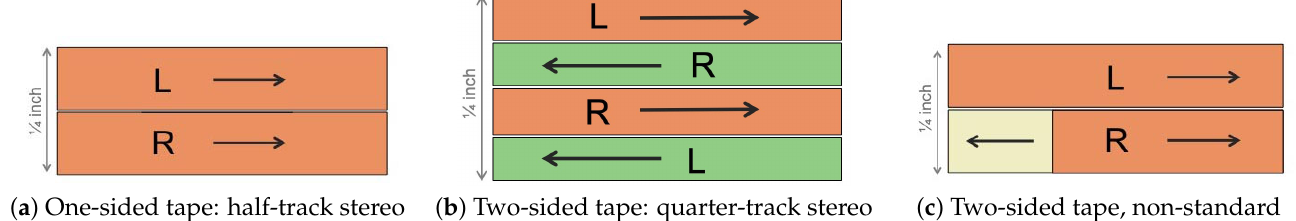
Figure 2. Examples of standard and non-standard track configurations on one- and two-sided tapes. Source: Bressan and Hess